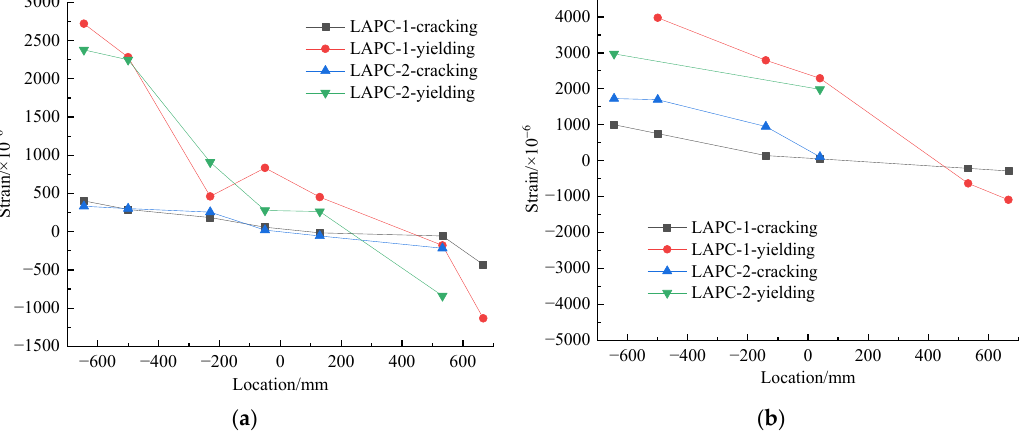
Figure 15. Strain distribution of longitudinal rebars above and below the sleeves of the precast walls during cracking and yielding: ( a ) 10 mm above the sleeve; and ( b ) 10 mm above the base beam.